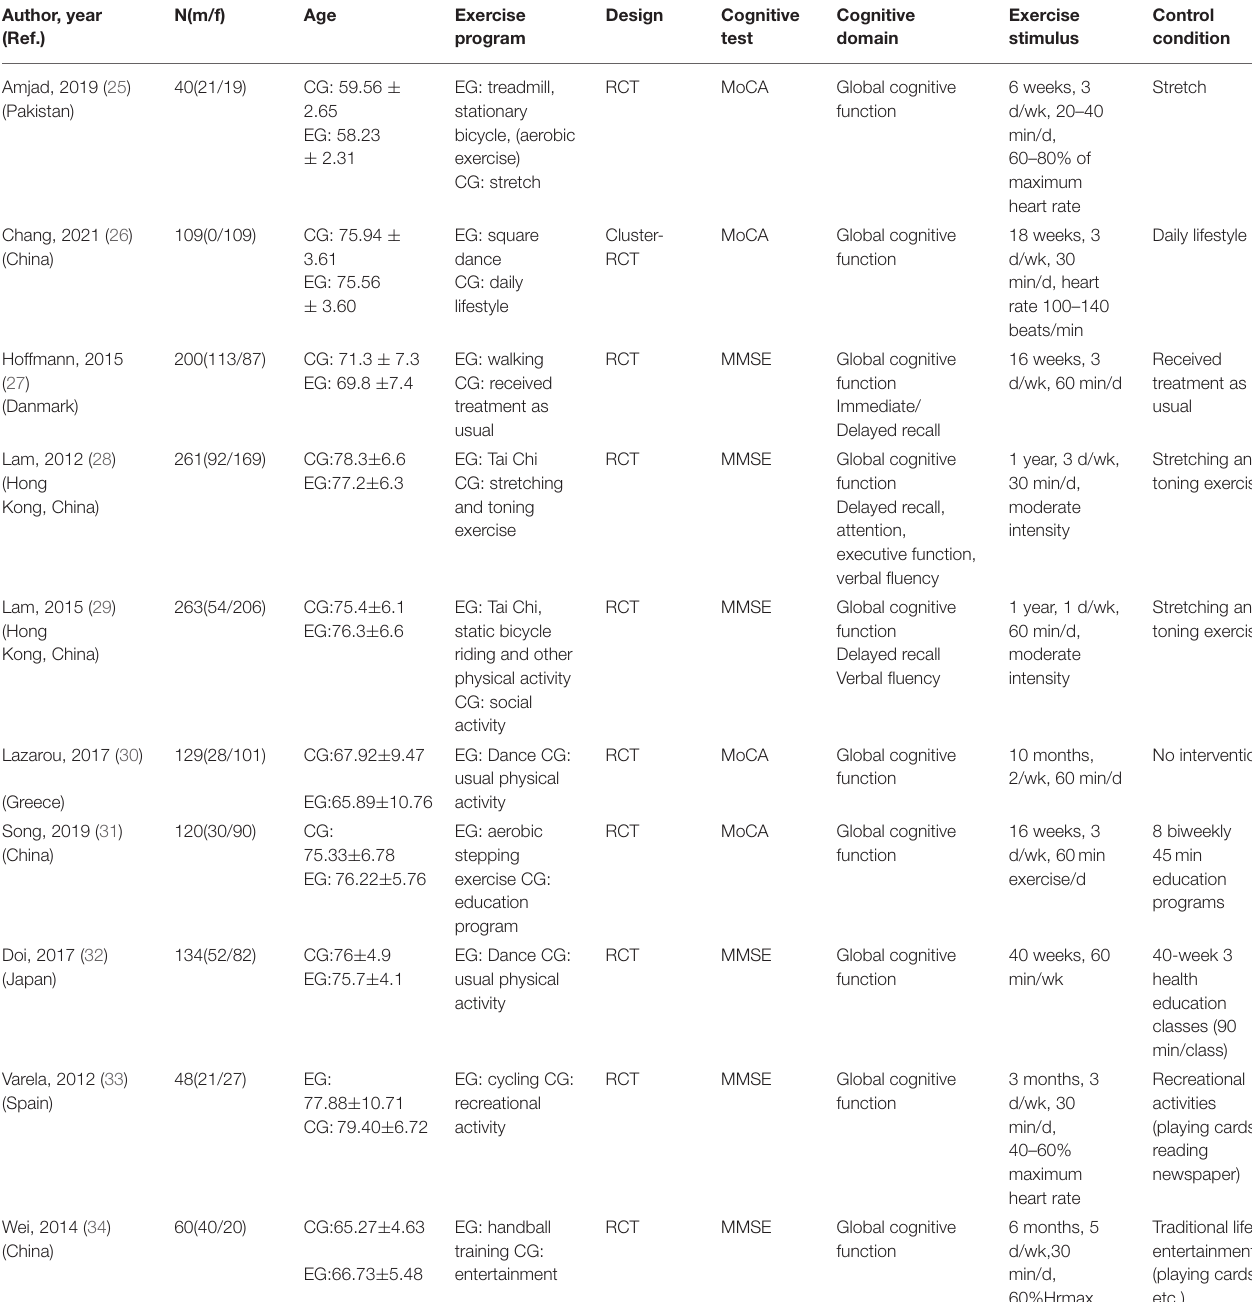
TABLE 1 | Characteristics of included trials in this review. Author, year